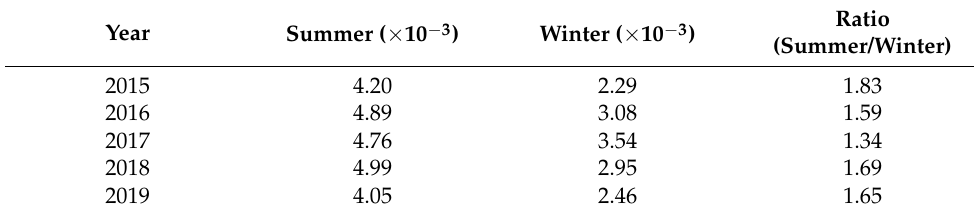
Table 1. Variations of EOF1 principal components.